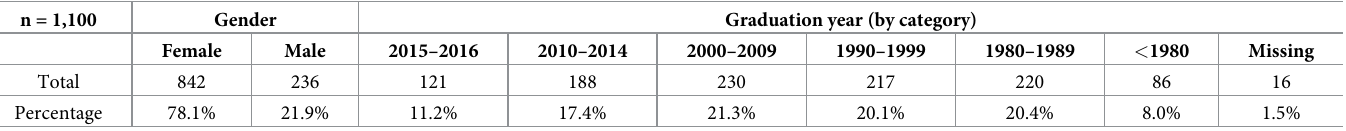
Table 1. Distribution of the gender and graduation year categories for respondents to the veterinary